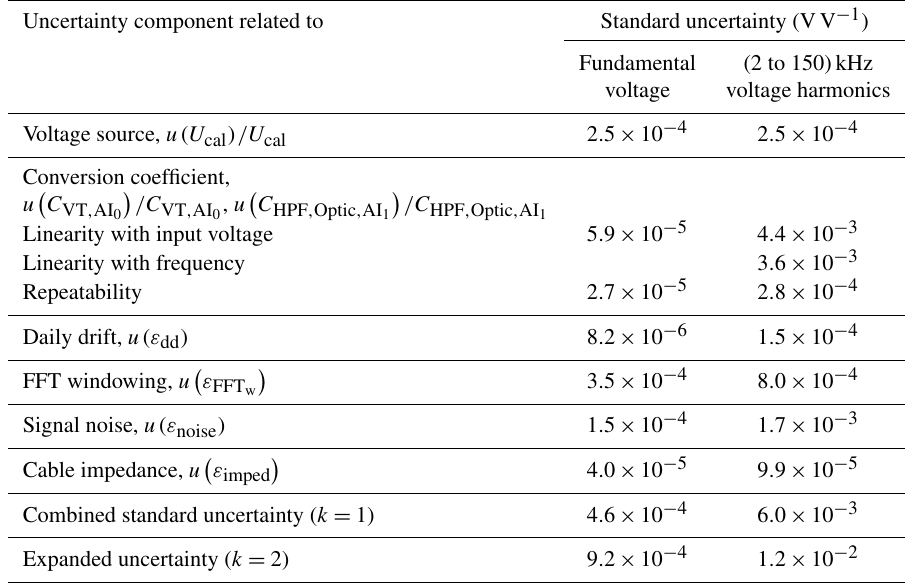
Table 1. Uncertainty budget for fundamental and (2 to 150)kHz voltage harmonics. Uncertainty component related